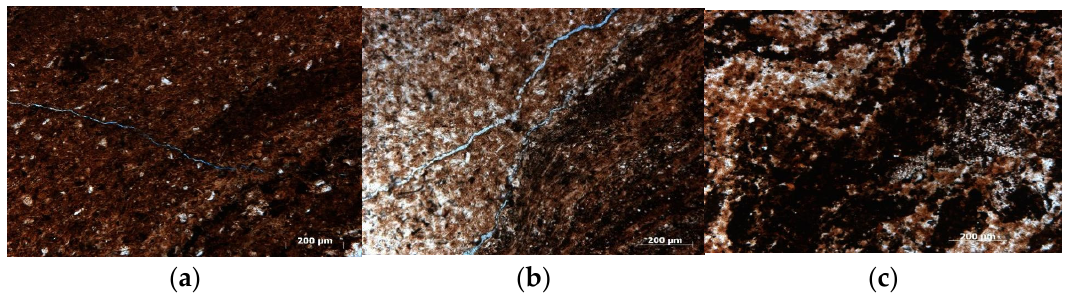
Figure 3. Results of casting thin section identification: ( a ) 0° sample without soaking treatment; ( b ) 45° sample soaked in water at room temperature for 48 h; ( c ) 45° sample soaked in drilling fluid at room temperature for 48 h.